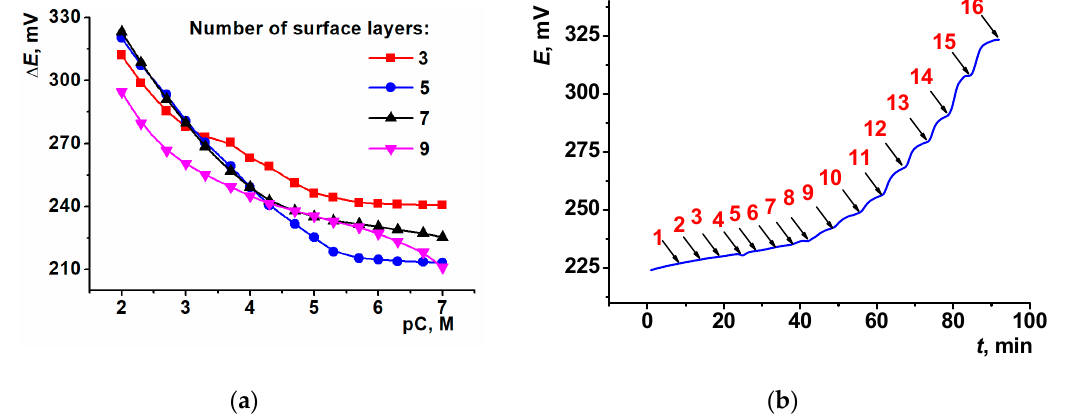
Figure 5. ( a ) Calibration curves of Cu 2+ ions obtained with different numbers of layers deposited on the polyaniline film: P[6]A—CuCl 2 —P[6]A (three layers); (P[6]A—CuCl 2 ) 2 —P[6]A (five layers); (P[6]A—CuCl 2 ) 3 —P[6]A (7 layers); (P[6]A—CuCl 2 ) 4 —P[6]A (nine layers); ( b ) dynamic response of the potentiometric sensor with seven layers on the addition of 0.1 µ M–10 mM CuCl 2 solution (concentrations corresponded to red numbers are presented with appropriate numbers in Table S1). Table 1. Analytical characteristics of Cu 2+ determination with potentiometric sensor based on GCE covered with polyaniline and P[6]A–Cu 2+ layers. Average results from individual sensors, measure- ments in triplicate in 0.1 M NaCl.